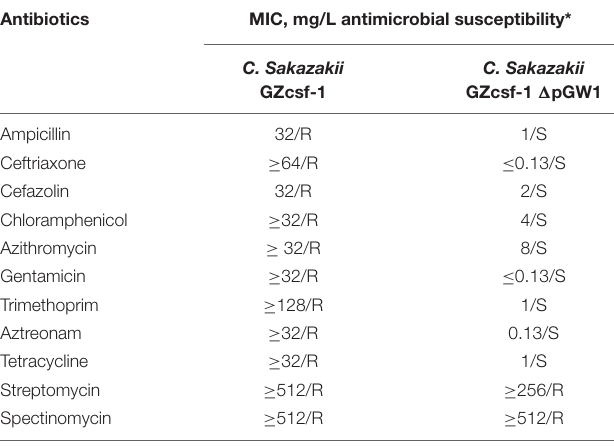
TABLE 1 | Antimicrobial drug susceptibility profiles. Antibiotics MIC, mg/L antimicrobial